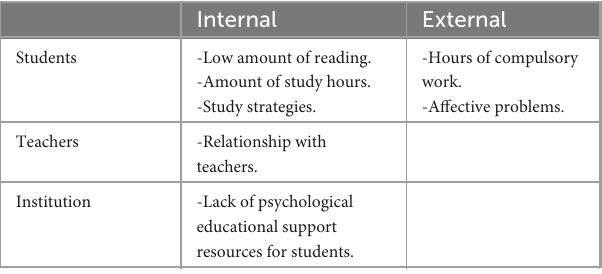
TABLE 1 Summary of factors contributing to failure at